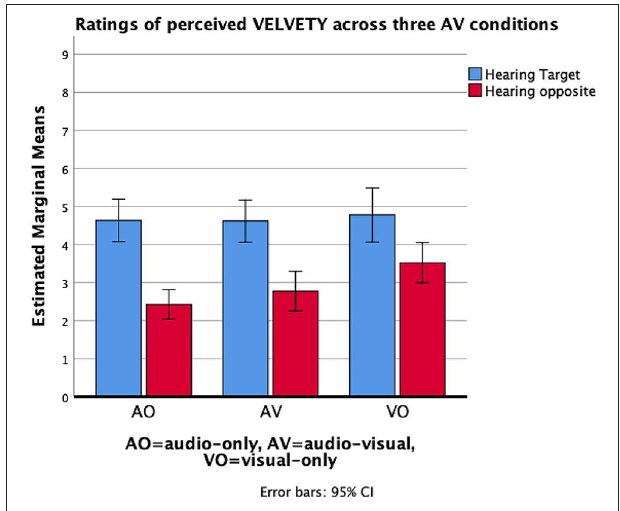
FIGURE 5 | Mean values of the evaluation of Velvety timbre across three AV stimuli found by averaging in piece/performer factor. Error bars represent confidence